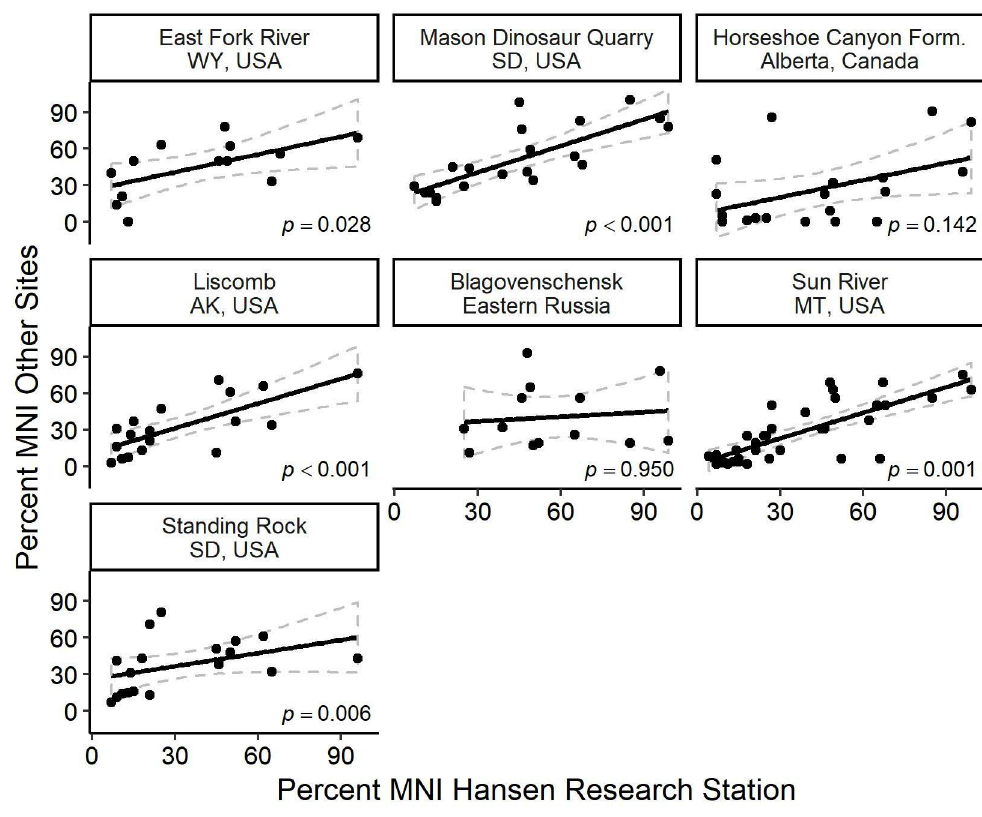
Fig 12. Correlations of percent MNI among published hadrosaurid bonebeds. The closer the individual dots are to the line, the more significant the correlation is. The gray dotted lines indicate the 95% confidence intervals around each black best-fit line. East Fork River [90], Mason Dinosaur Quarry [10], Liscomb [6], Blagovenschensk [44], Sun River [51], Standing Rock [9].